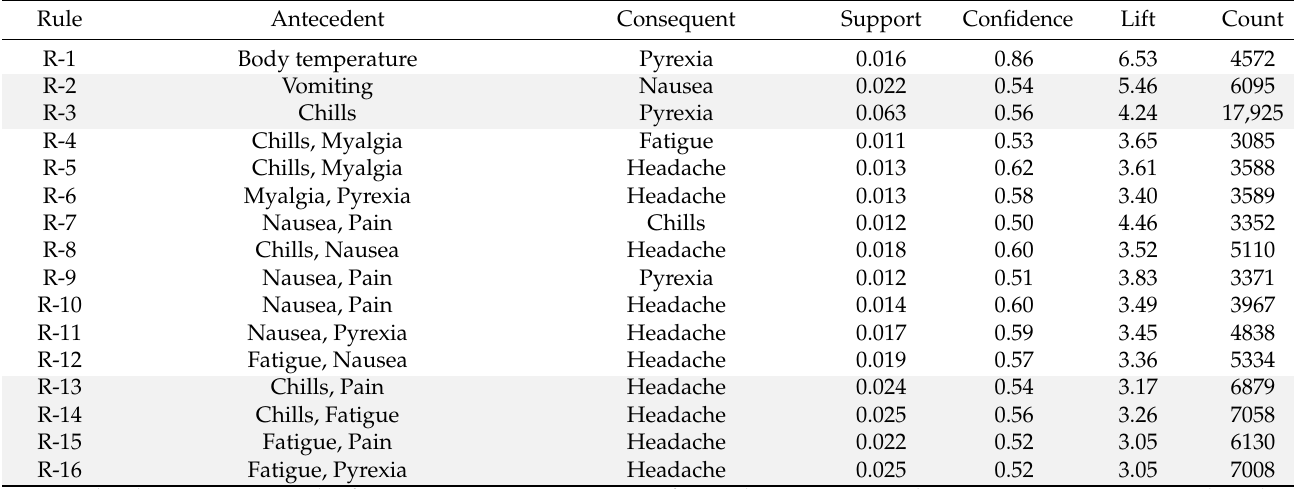
Table 4. The similarity between AEs as represented by the 2D SOM is indicative of the